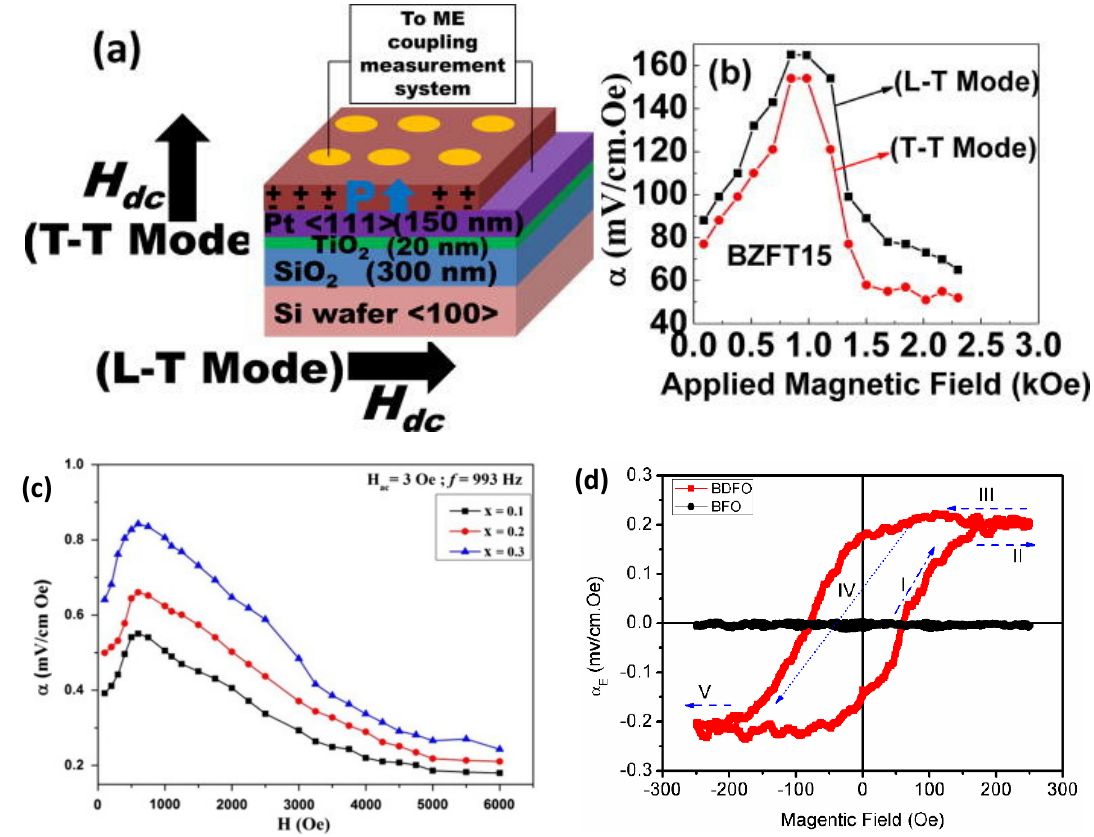
Figure 6. ( a ) The schematic representation of the experimental conditions; and ( b ) M–E coupling coe ffi cient versus applied magnetic field measured in both in-plane magnetized-out of plane polarized configuration (L–T) and out of plane magnetized-out of plane polarized (T–T) modes. Reproduced with permission from [25]. ( c ) ME coe ffi cient for a H AC = 3 Oe at 993 Hz [26]. ( d ) MEP (H) hysteresis loops displayed at 300 K, showing the variations of the ME coe ffi cient as a function of the applied magnetic field for of BDFO (red) and BFO (black). Reproduced with permission from [28] .